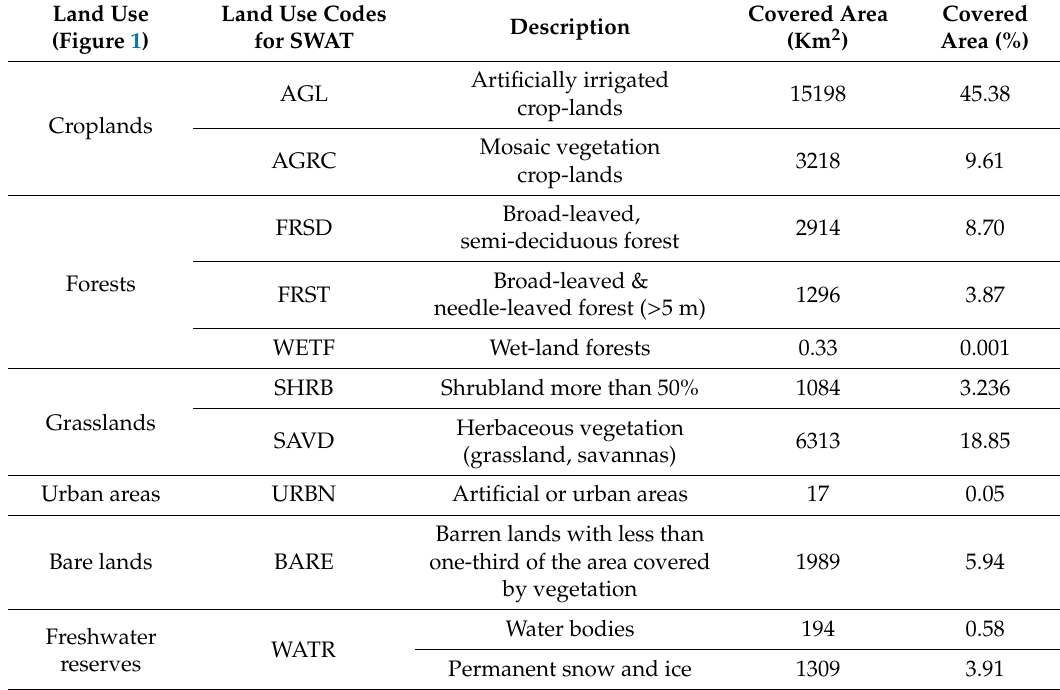
Table 1. The United States Geological Survey (USGS) Soil and Water Assessment Tool (SWAT) land use